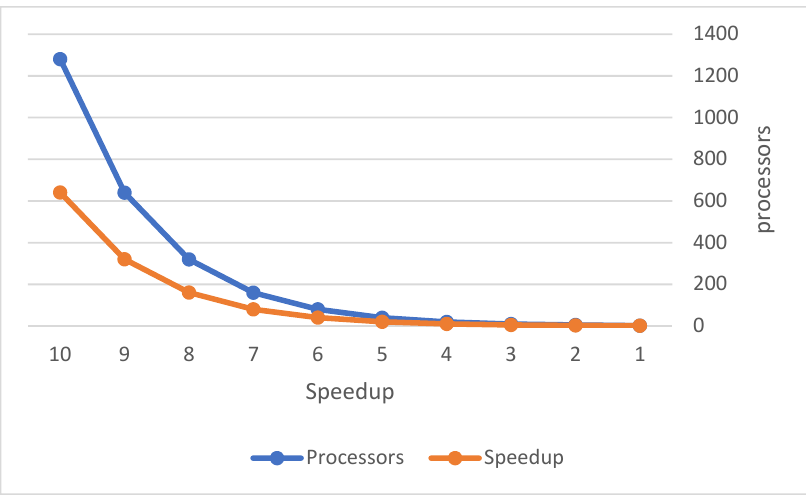
Figure A2. The relation between populations and execution time in the GA.